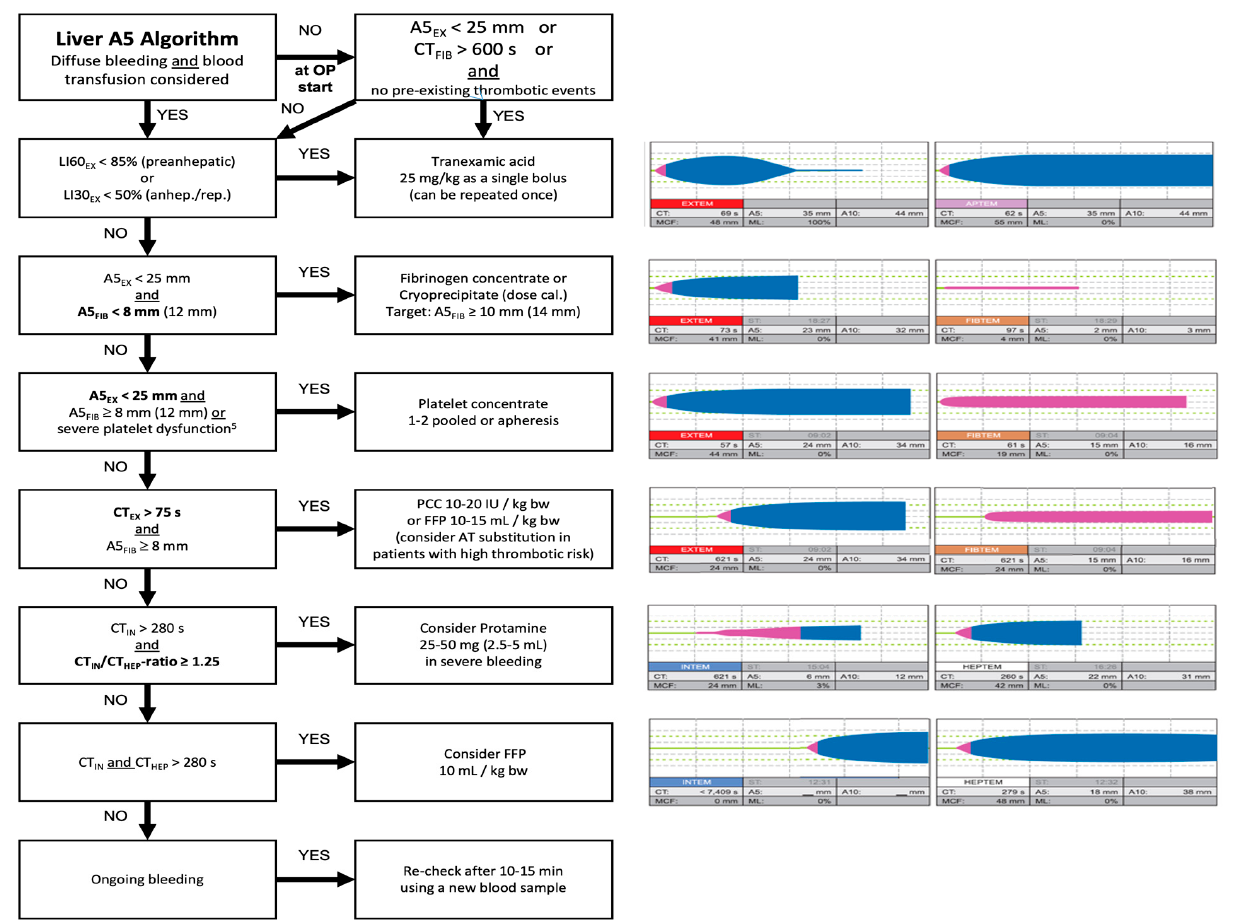
Figure 2. A5 EX : amplitude of clot fi rmness 5 min after coagulation time in EXTEM, CT FIB : coagulation